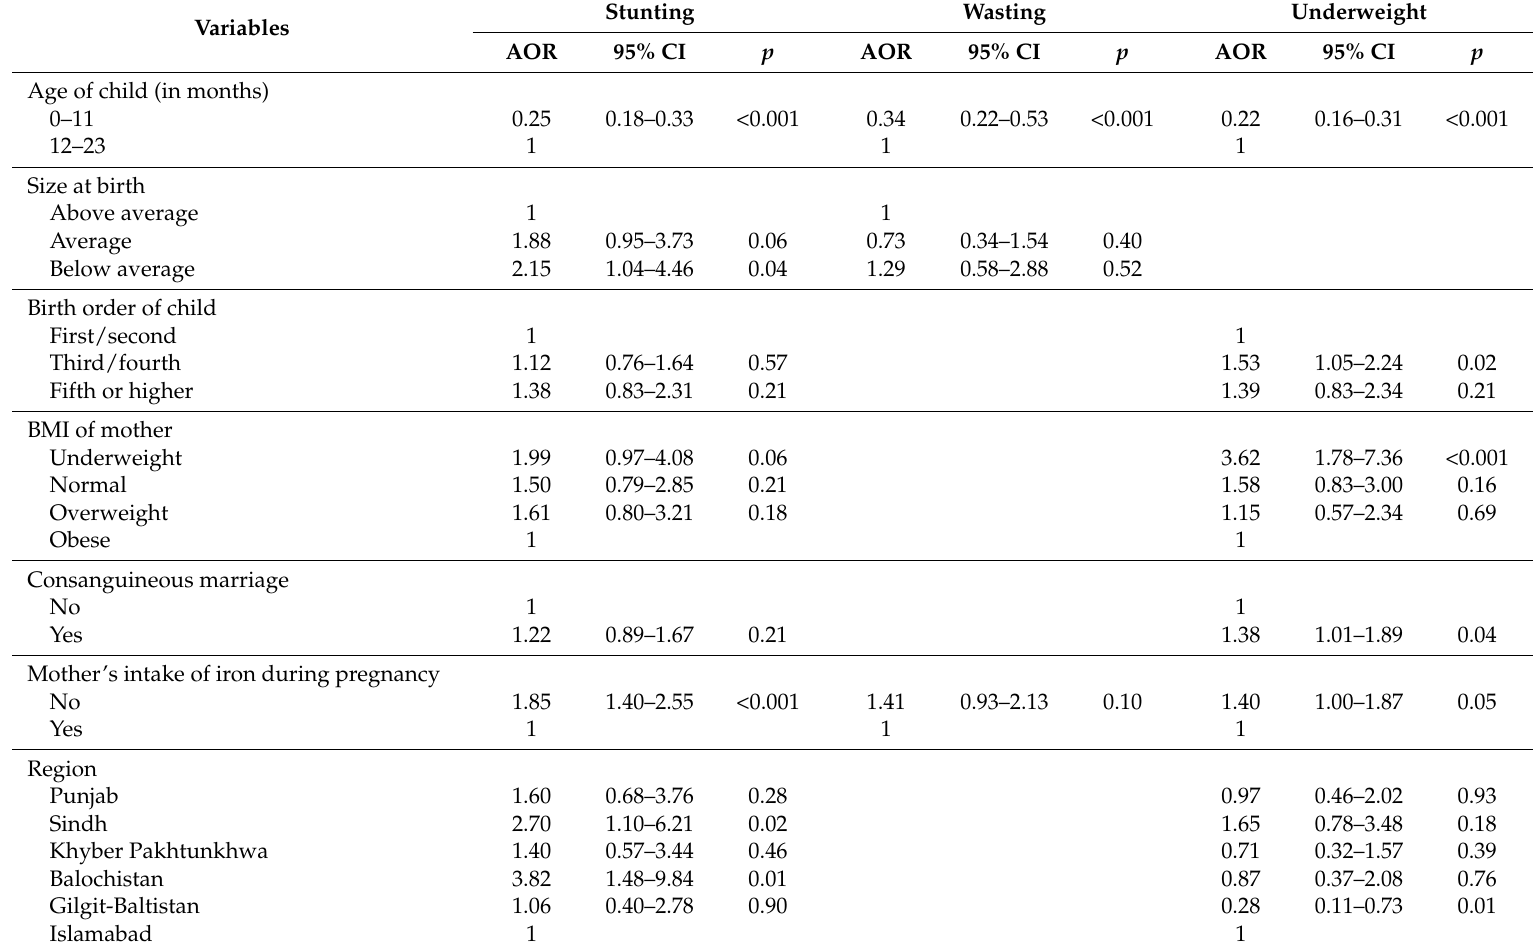
Table 4. Multivariable logistic regression for factors associated with stunting, wasting, and underweight in children under two years of age. Stunting Wasting Variables